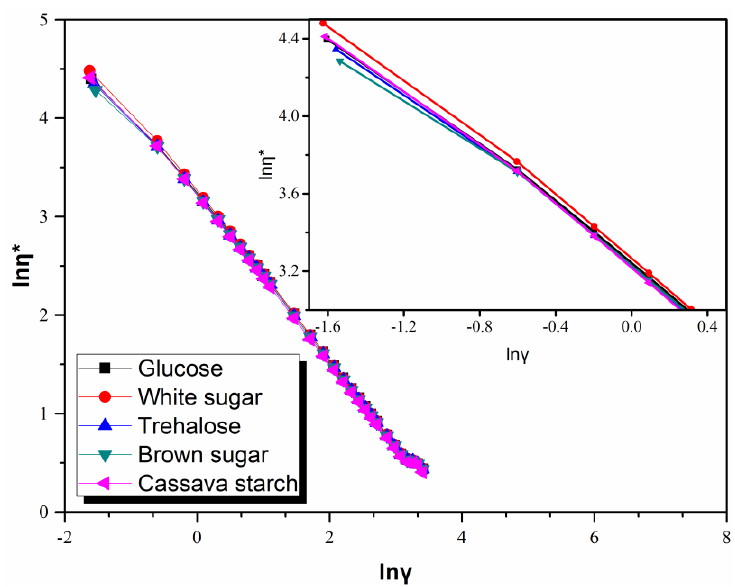
Figure 8. Relationship between lnη* and lnγ of raw natural rubber resulted from coagulation using different sugars.